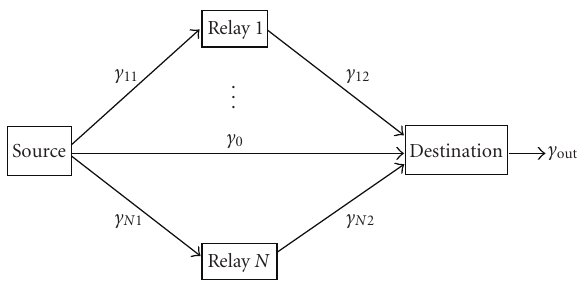
Figure 1: Cooperative dual-hop relay transmission scheme with MRC at the